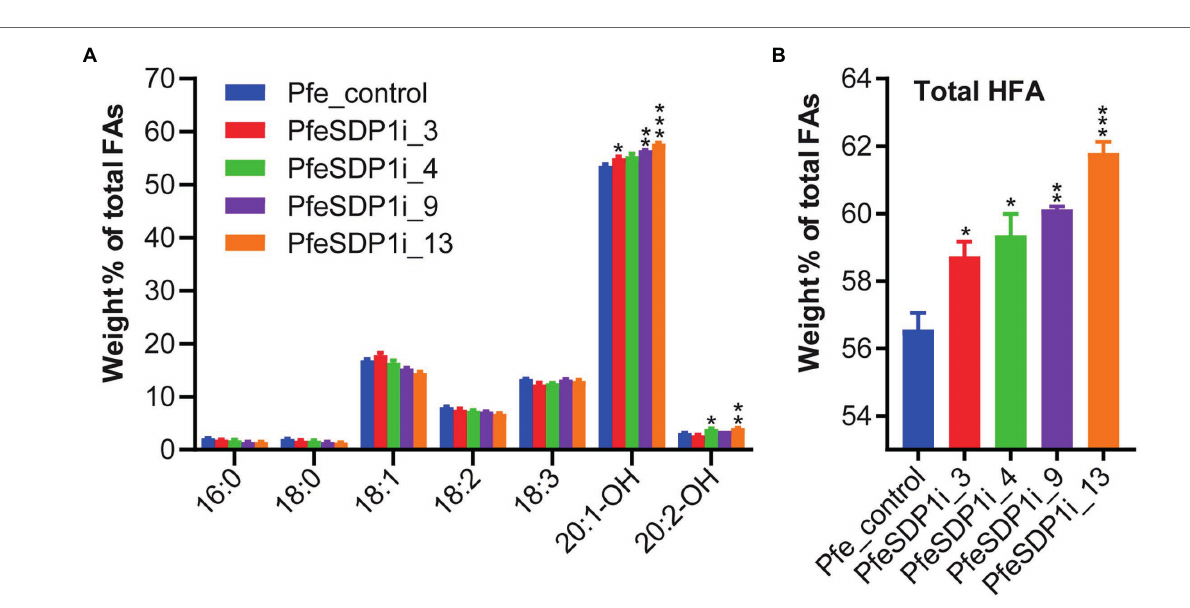
FIGURE 5 | Increased proportion of hydroxy fatty acids in PfeSDP1_RNAi seeds. (A) Weight percent of total fatty acids (FA) of PfeSDP1_RNAi lines 3, 4, 9, and 13. (B) Total HFAs combined (18:1-OH, 18:2-OH, 20:1-OH, and 20:2-OH). Data represents mean ± SEM ( n = 3–10) per line. Additional minor fatty acids (18:1-OH, 18:2- OH, 20:0, 20:1) each representing less than 1% of total fatty acids are included in Supplementary Table S3 . Asterisks (*), (**), and (***) indicate significant differences at p ≤ 0.05, ≤ 0.002, and ≤ 0.0006 compared to their respective control by two-tailed paired t -tests.